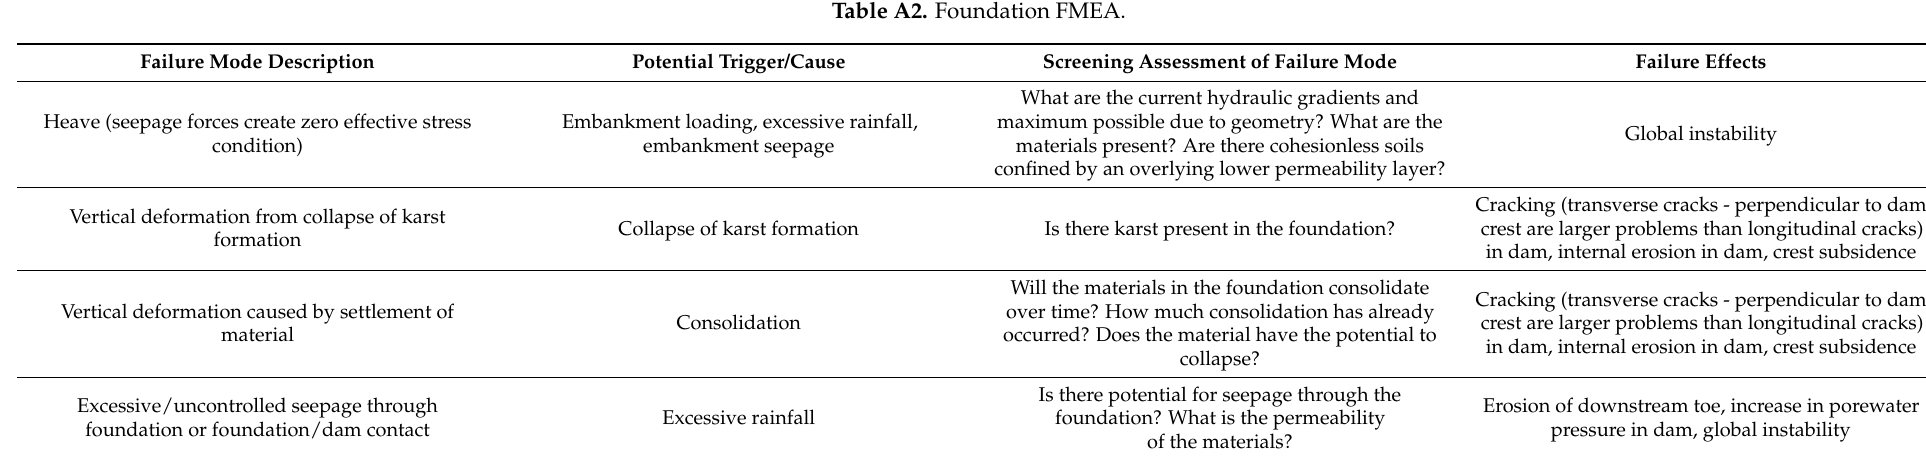
Table A2. Foundation